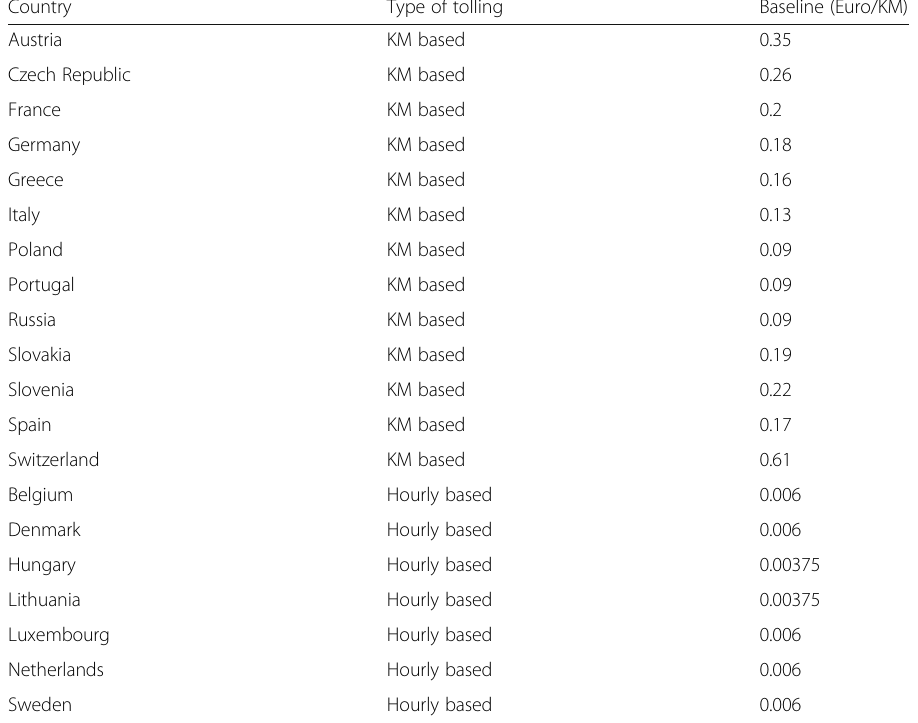
Table 6 Reference scenario for kilometre-based truck tolls, source: Hylen et al. (2013) Country Type of tolling Baseline